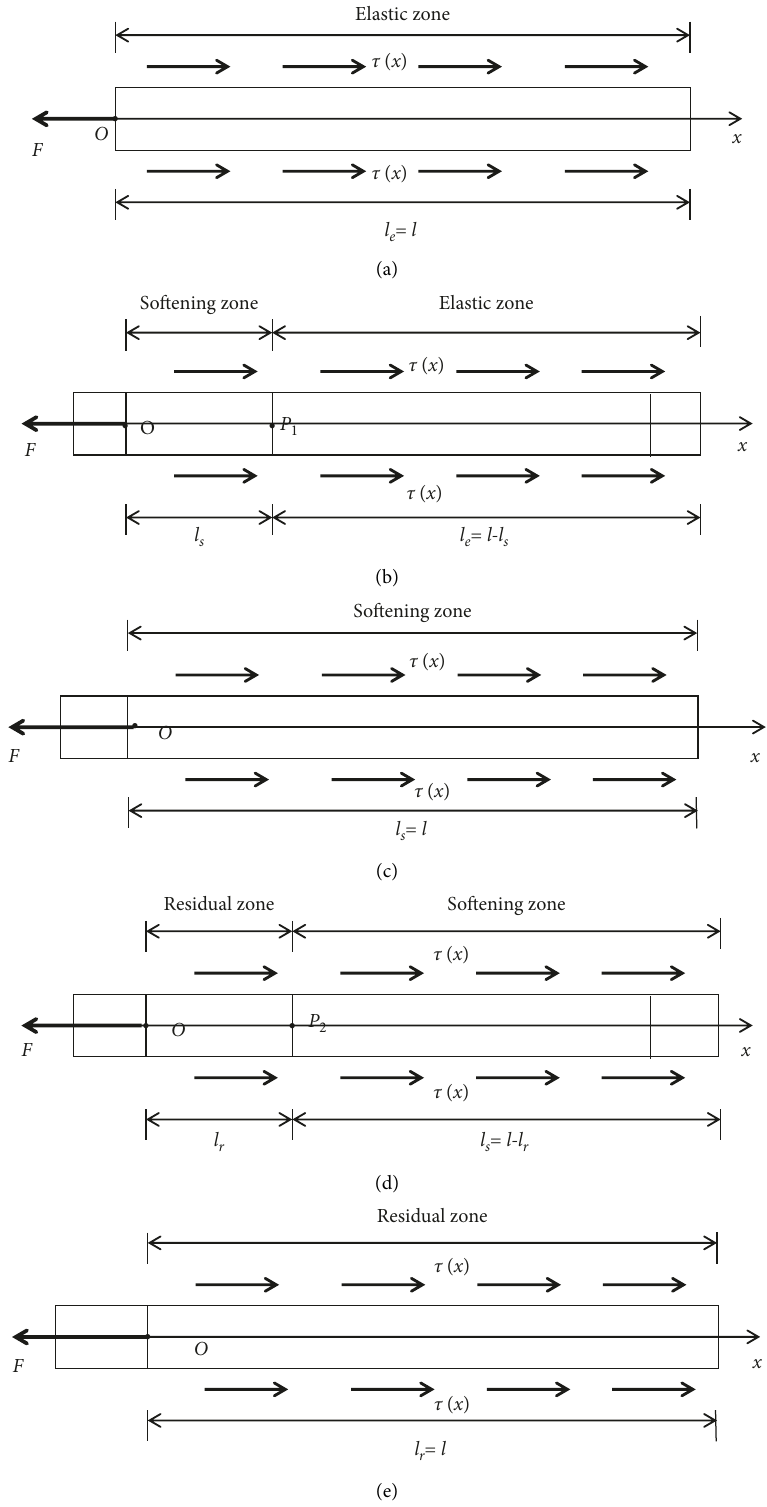
Figure 9: Progressive pullout process of geogrid in softening model. (a) Elastic phase. (b) Softening-elastic phase. (c) Softening phase. (d) Residual-softening phase. (e) Residual